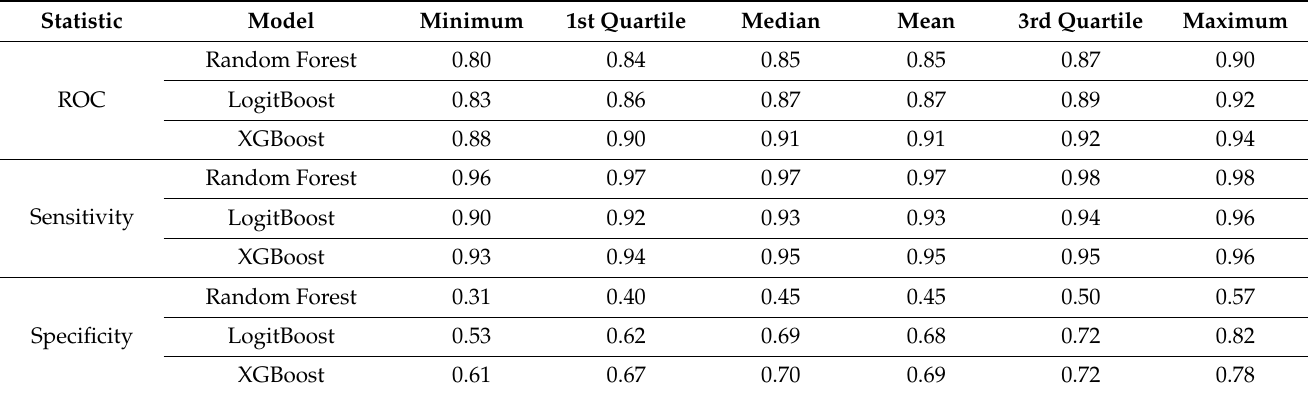
Table 2. Machine learning model comparison using training